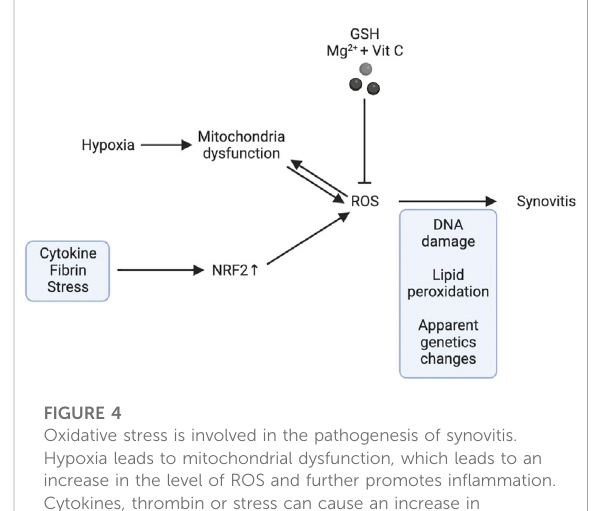
FIGURE 4 Oxidative stress is involved in the pathogenesis of synovitis. Hypoxia leads to mitochondrial dysfunction, which leads to an increase in the level of ROS and further promotes in fl ammation. Cytokines, thrombin or stress can cause an increase in nuclearfactorerythroid2p45-relatedFactor2(NRF2),whichleads to an increase in ROS. The combination of Mg 2+ and vitamin C can reduce oxidative stress and synovitis in OA. At the cellular level, oxidative stress can cause DNA damage, lipid peroxidation and epigenetic changes in gene expression, leading to synovitis